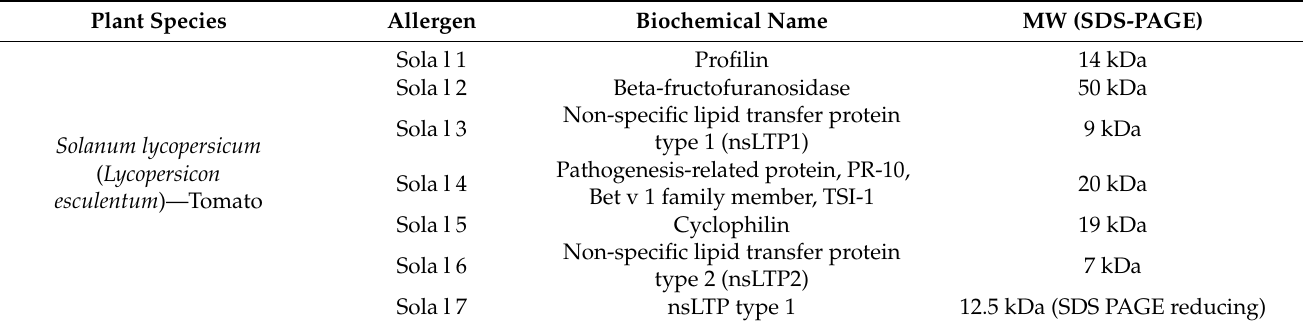
Table 3. Tomato allergens, all officially listed by The International Union of Immunological Societies *. Plant